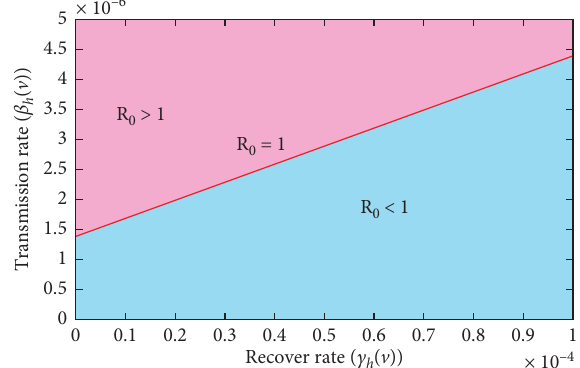
c u � 0 h with h and